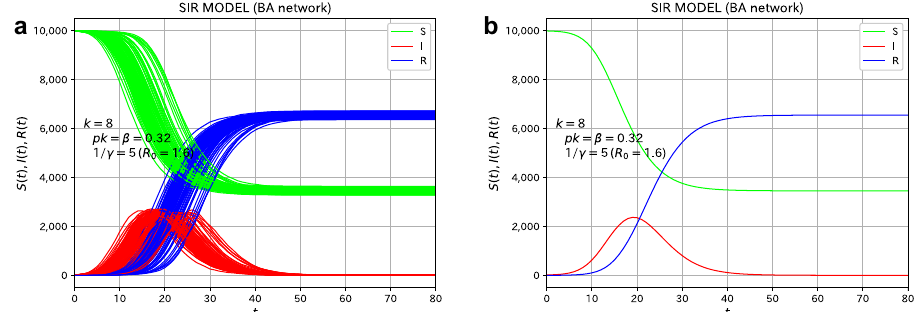
Figure 6. The simulational results of the microscopic SIR model on the BA network (reference system with no variants). ( a ) The plot of all 100 samples assumed to be infected with the virus with R 0 = 1.6 . ( b ) The average over 100 samples. Initially, 10 individuals were set to be infected.